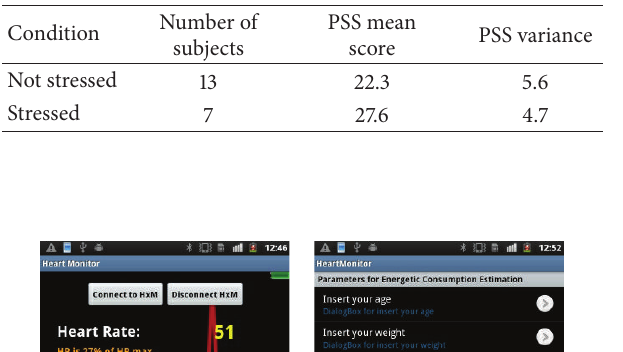
Table 3: Results of the stress test algorithm.